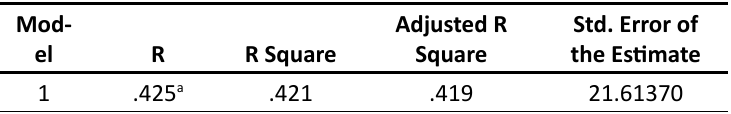
Table 7: Coefficient Determination Test